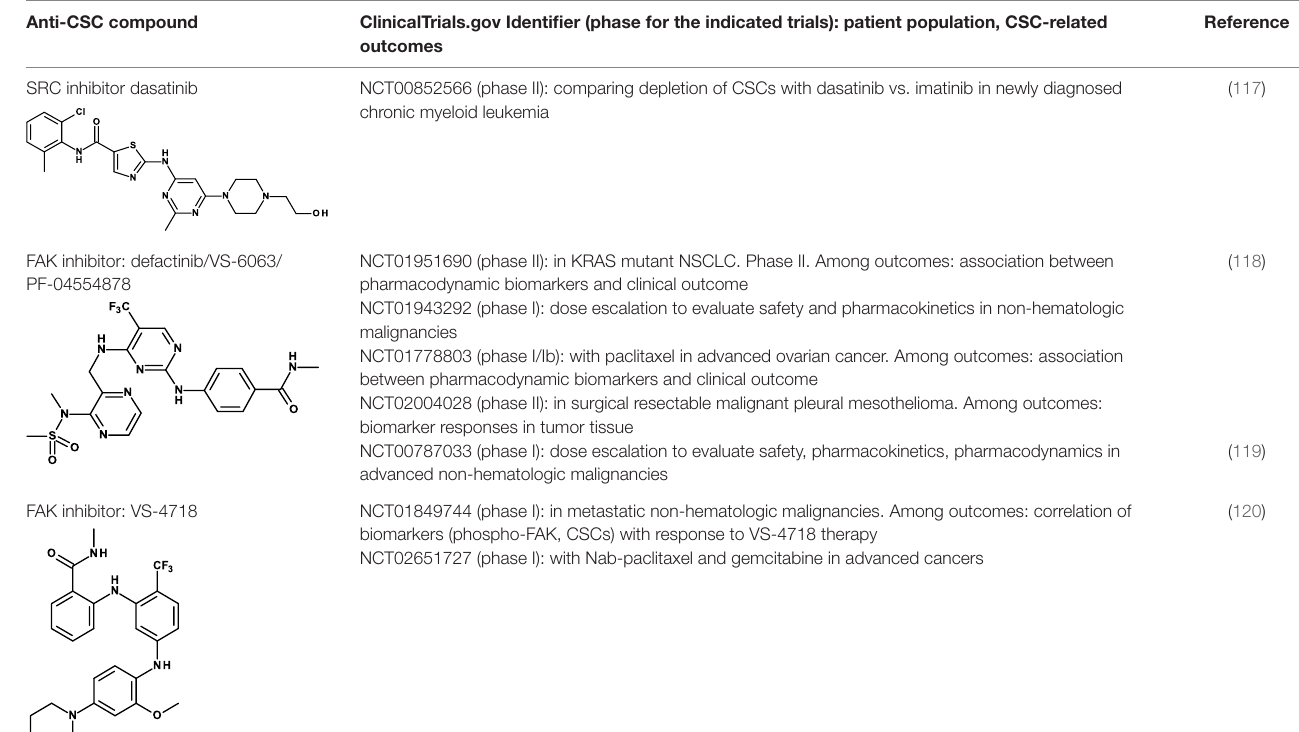
TABLe 3 | Anti-CSC compounds that inhibit post-receptor signaling pathways. Anti-CSC